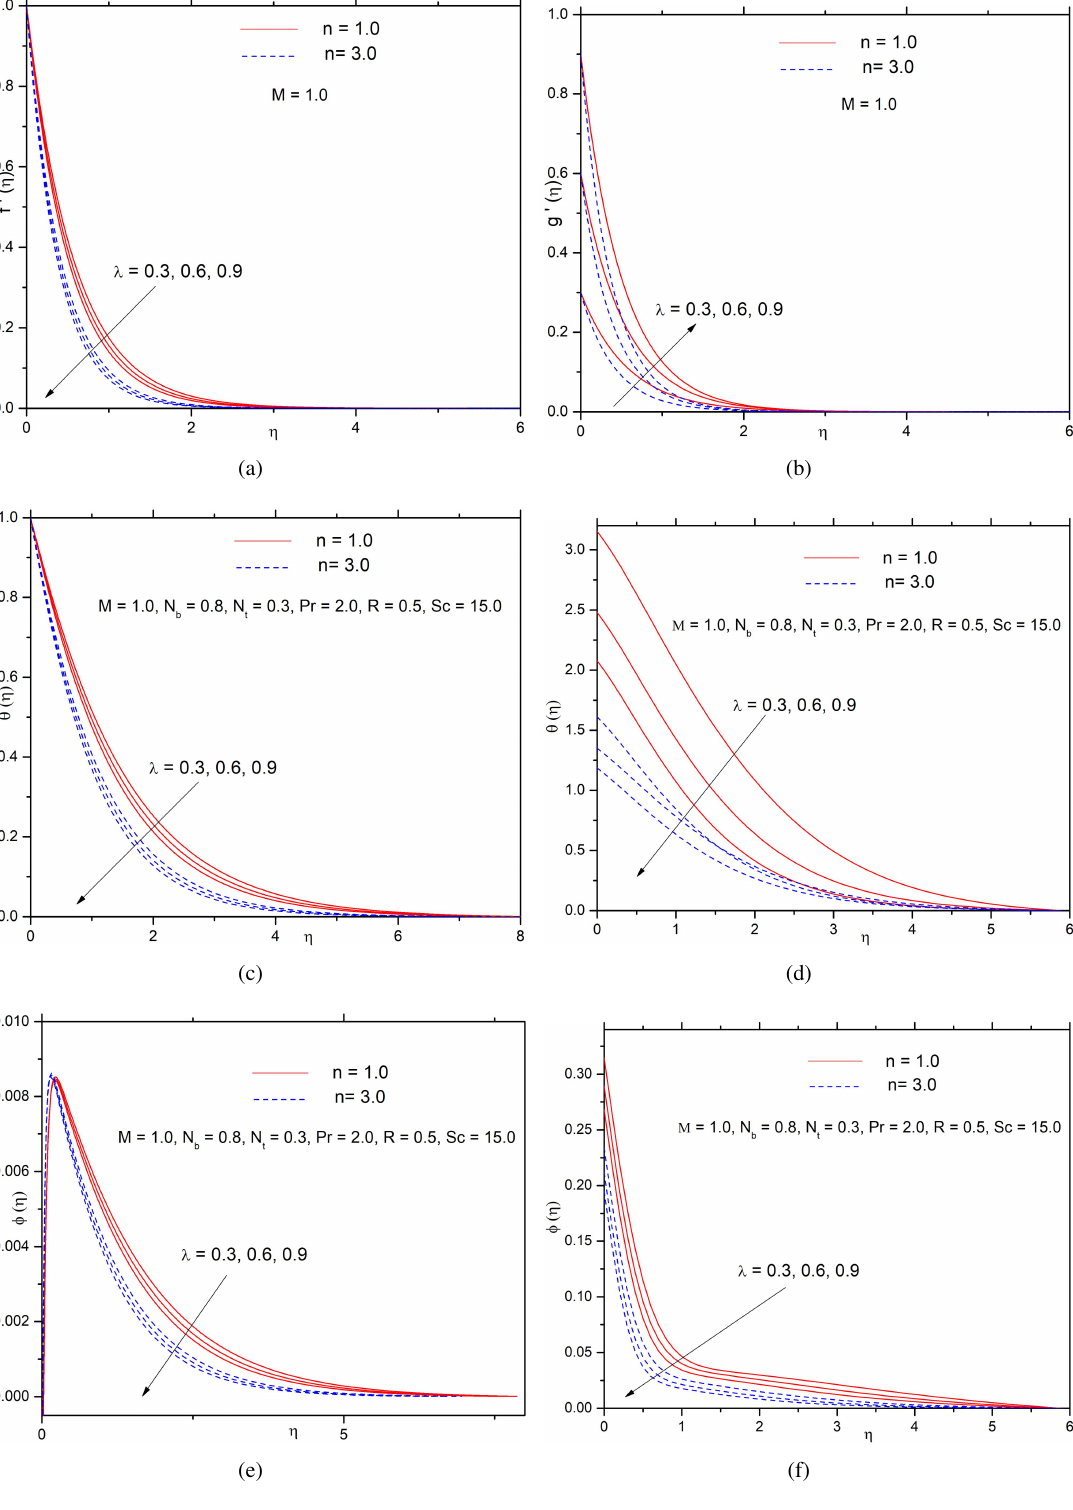
Fig. 3 Influences of λ , stretching ratio parameter on (a) f (cid:48) ( η ) , velocity in the direction of x (b) g (cid:48) ( η ) , velocity in the direction of y , temperature θ ( η ) for (c) CWT and (d) PHF and nanoparticle volume fraction ϕ ( η ) for (e) ZMF and (f)